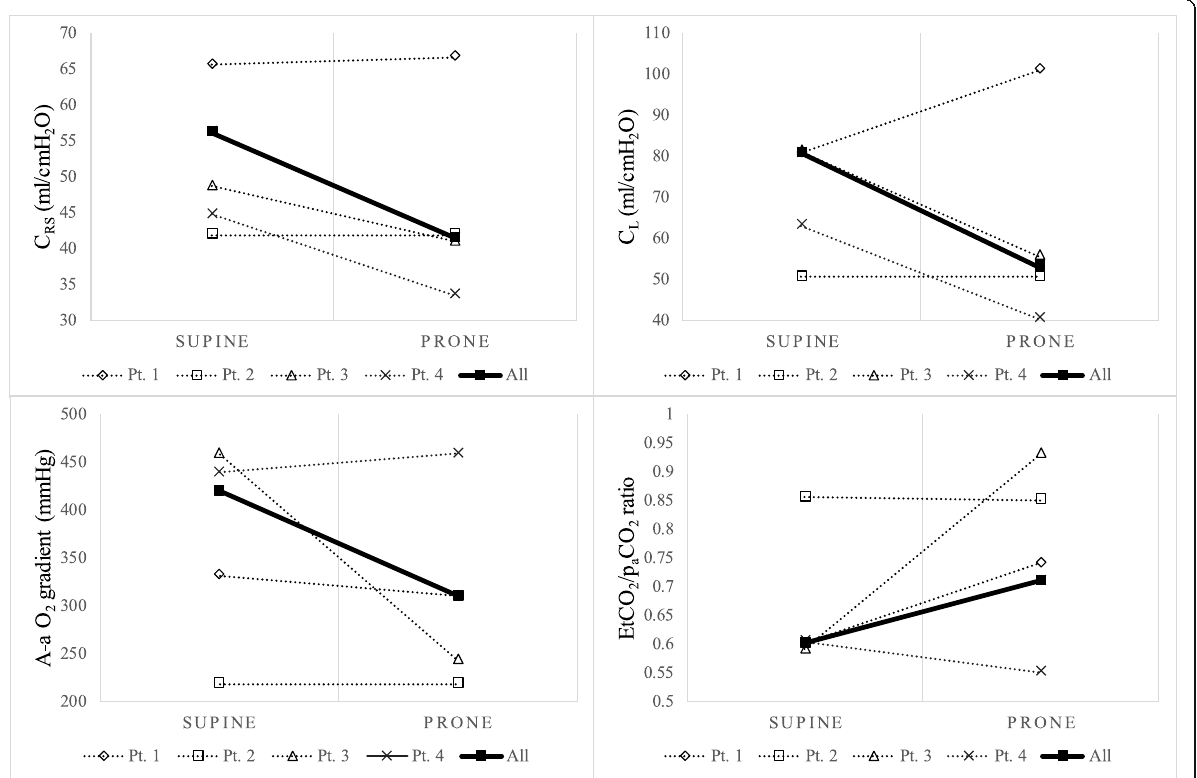
Fig. 1 Mechanical and Ventilation/Perfusion ratio variations in supine and prone positioning, just before decubitus change. C RS : Respiratory System Compliance; C L : Transpulmonary Compliance; A-aO 2 gradient: alveolar-to-arterial oxygen gradient; EtCO 2 /p a CO 2 ratio: end-tidal CO 2 to p a CO 2